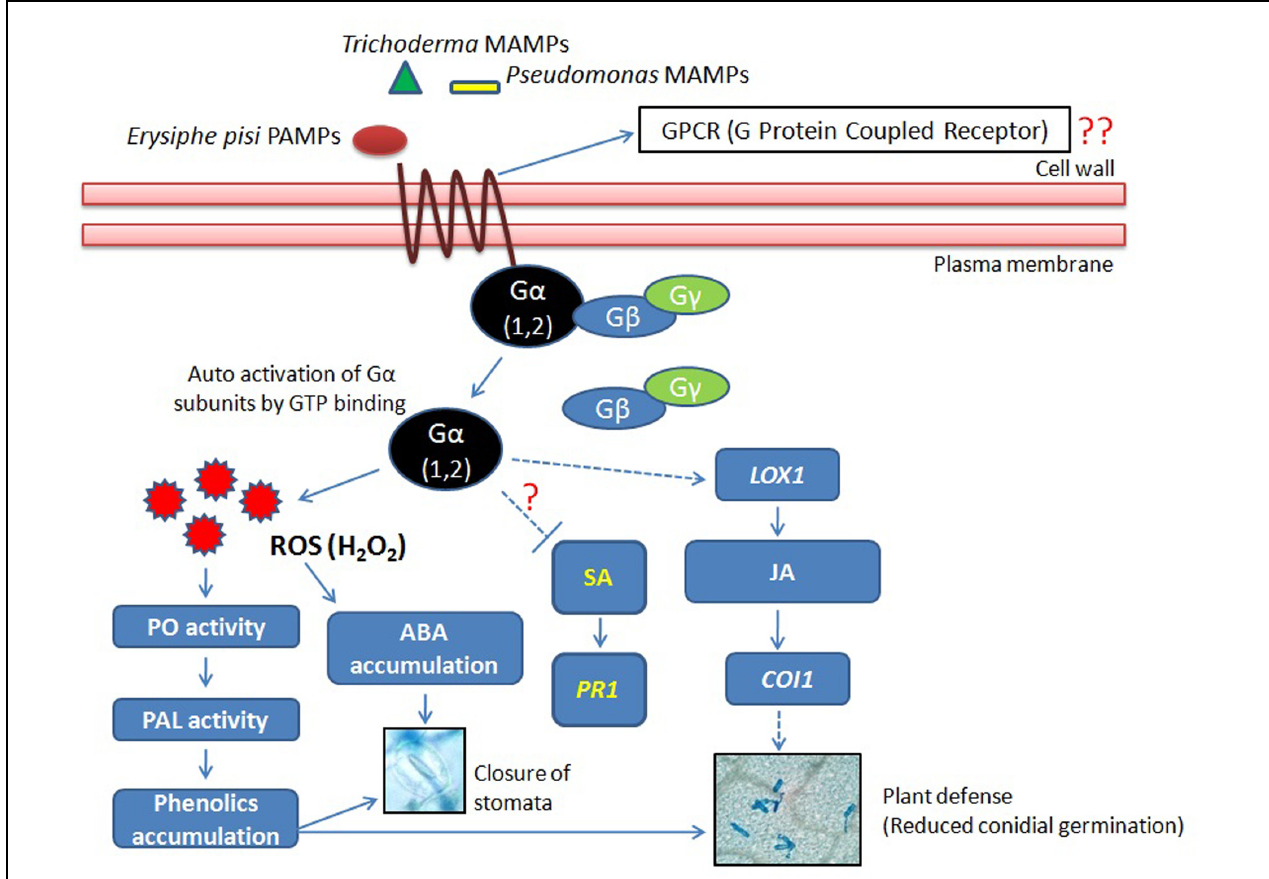
FIGURE 8 | Co-inoculation of P. fluorescens OKC and T. asperellum T42 as pretreatment stimulate transcript accumulations of G α subunits 1 and 2 of the heterotrimeric G protein during E. pisi challenge. The co-inoculated microbes also generated reactive oxygen species (ROS) H 2 O 2 but its concentration was regulated by activities of peroxidases. ROS generation also stimulated activities of the first gene of the phenyl propanoid pathway PAL that perhaps led to phenol accumulation in pea during infection by E. pisi. The signal transduction due to activation of G α subunits was possibly mediated through JA in pea under stimulus of the microbes and the cumulative effect of co-inoculated microbes had a suppressive effect on E. pisi conidial development on pea